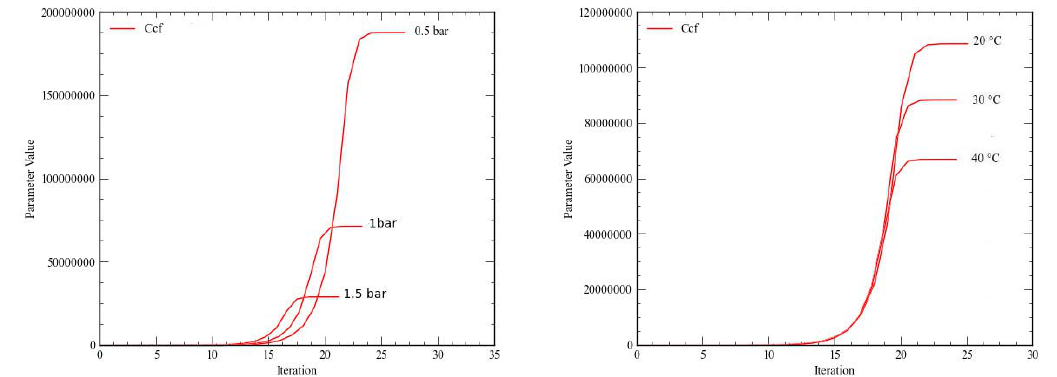
Fig. 8: Calculated cake formation fitted parameter vs. iteration by CurveExpert at different pressures (a) and different temperatures